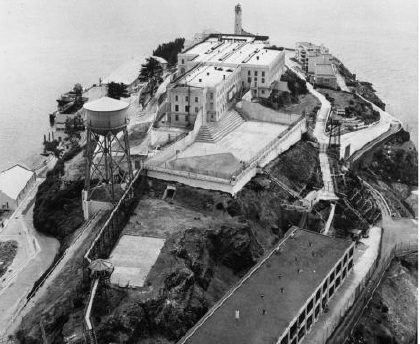
Figure 1. Alcatraz Aerial 1960s (ACLR 2010)